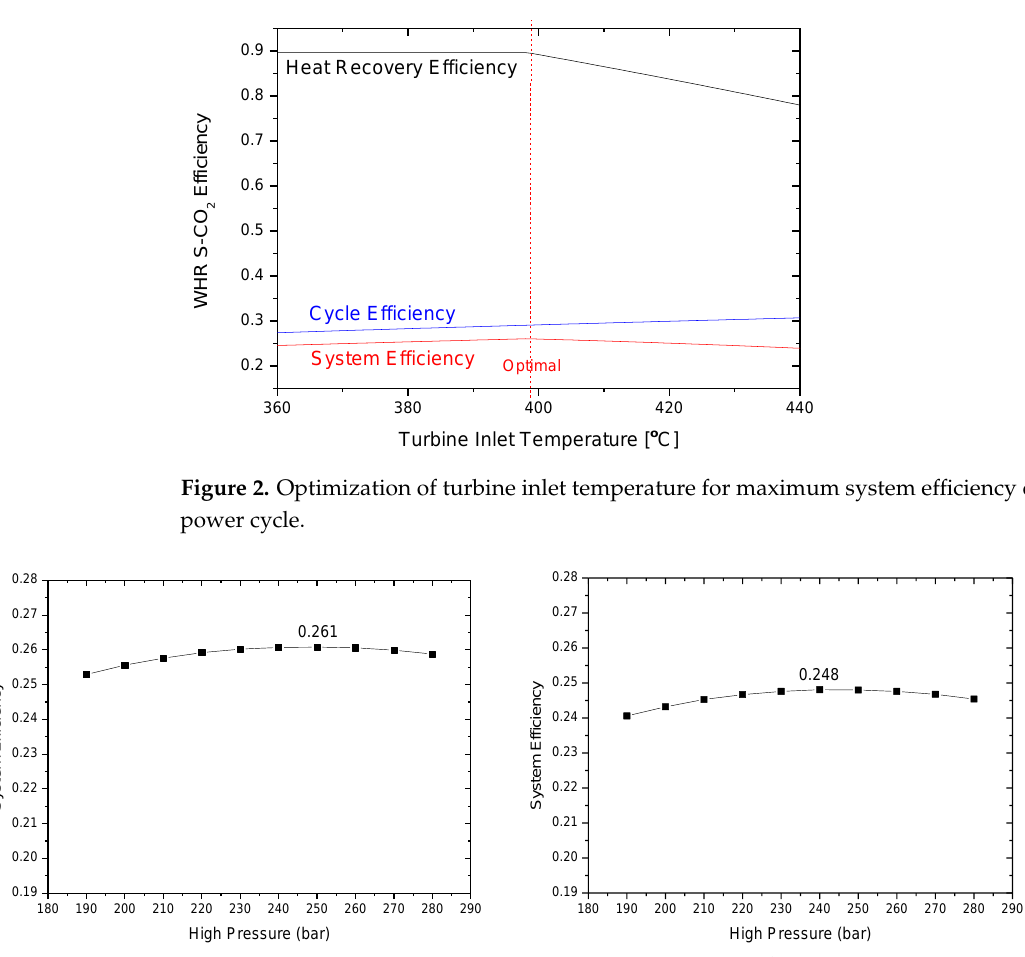
Figure 3. System efficiency of S-CO 2 power cycle for high-pressure side at given cooling temperature: ( a ) 20 °C; ( b ) 25 °C.